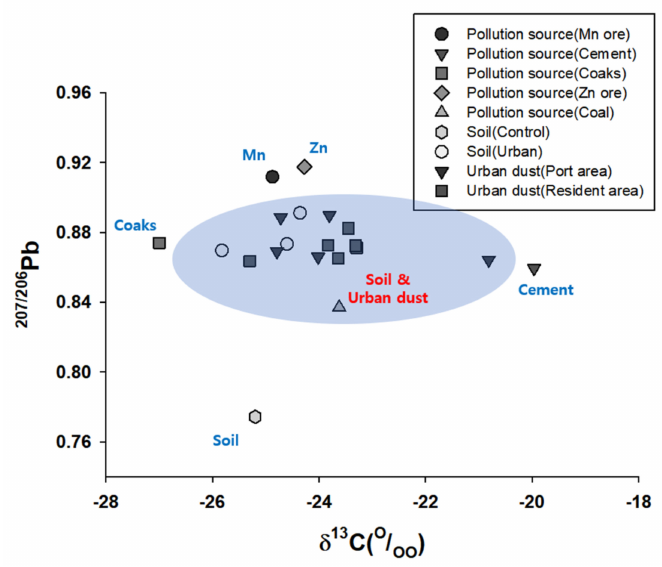
Figure 6. Scatter plot δ 13 C vs. 207 Pb/ 206 Pb of soil and urban dust in Donghae